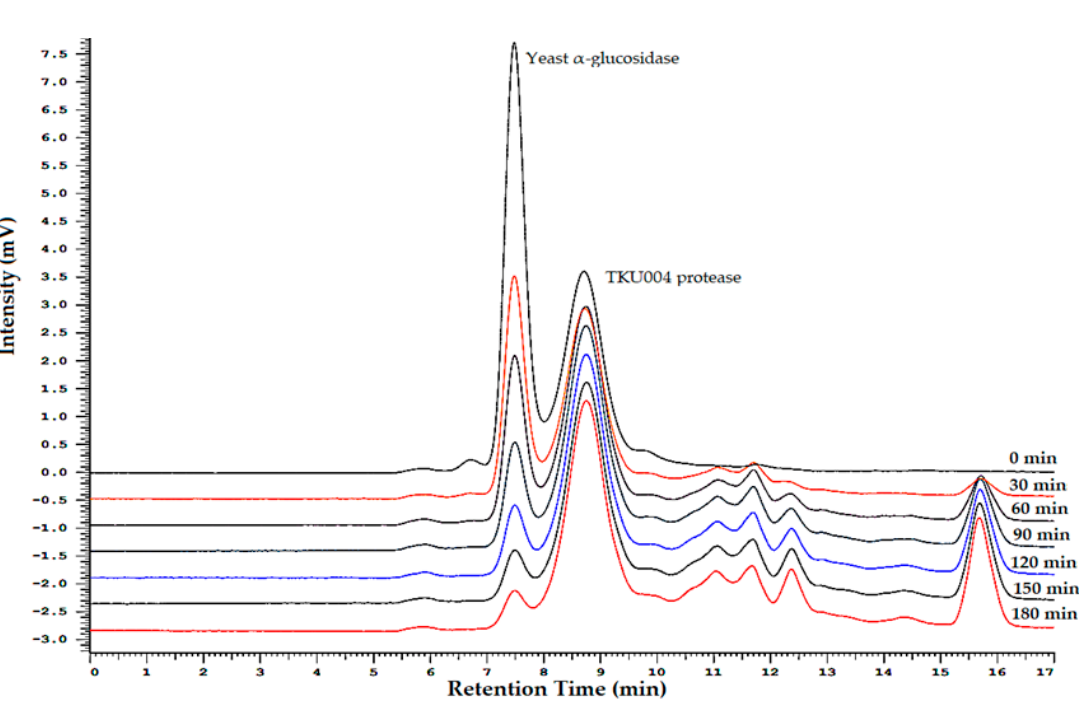
Figure 5. HPLC analysis of the time-course reaction of TKU004P and yeast α -glucosidase.